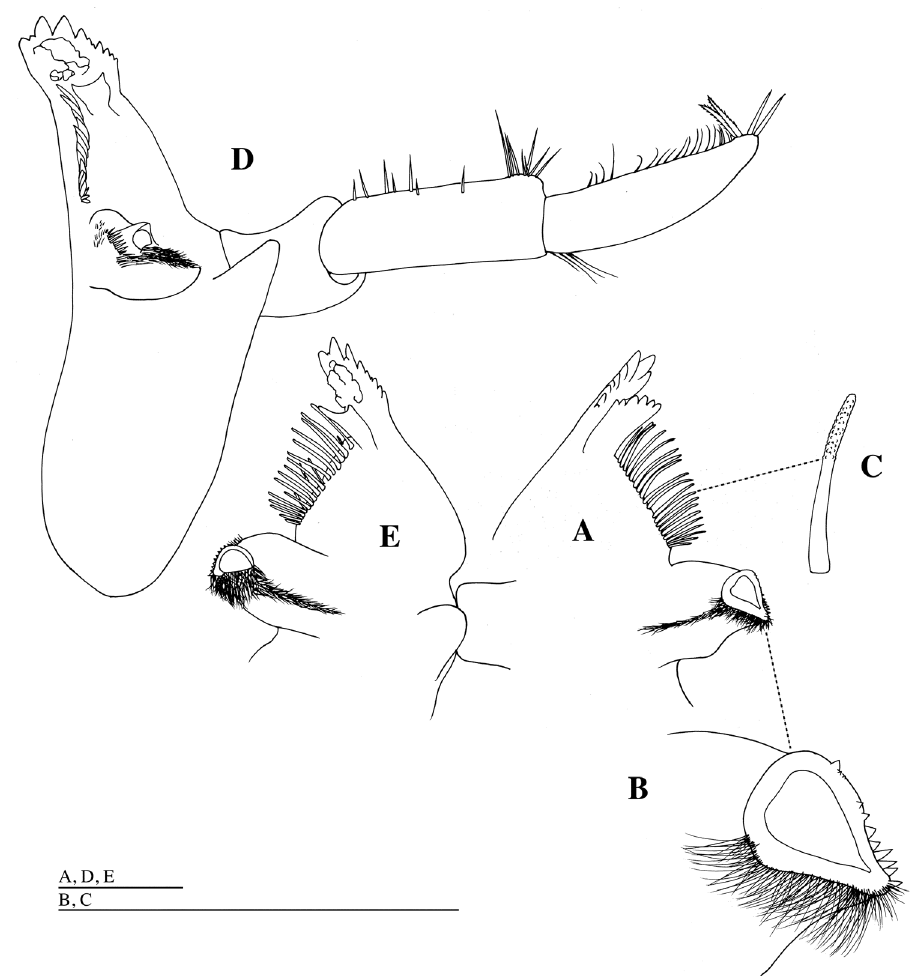
Figure 3. Epimeria abyssalis sp. n., holotype female: A molar process, incisor, lacinia mobilis and setal row of left mandible, dorsal B molar process of left mandible, dorsal C seta of setal row of left mandible, dorsal D right mandible, medial E molar process, incisor and setal row of right mandible, dorsal. Scale bars: 1